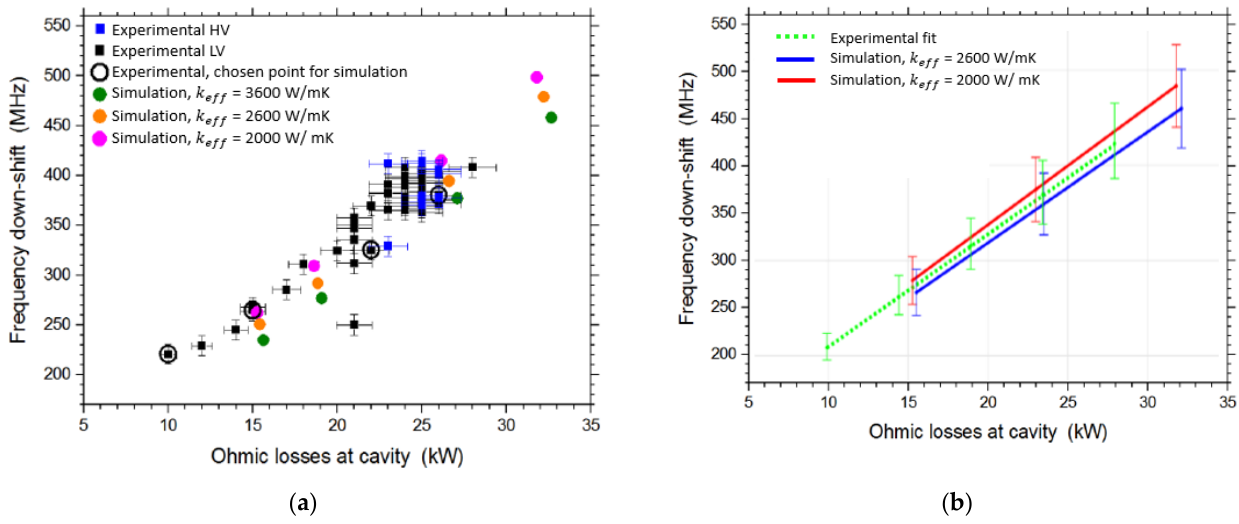
Figure 6. Comparison between the measured and computed frequency shift for several low-voltage (LV) and high-voltage (HV) operating points, as a function of the Ohmic power dissipated at the cavity. ( a ) Detailed map of tested and computed points; ( b ) linear interpolation.